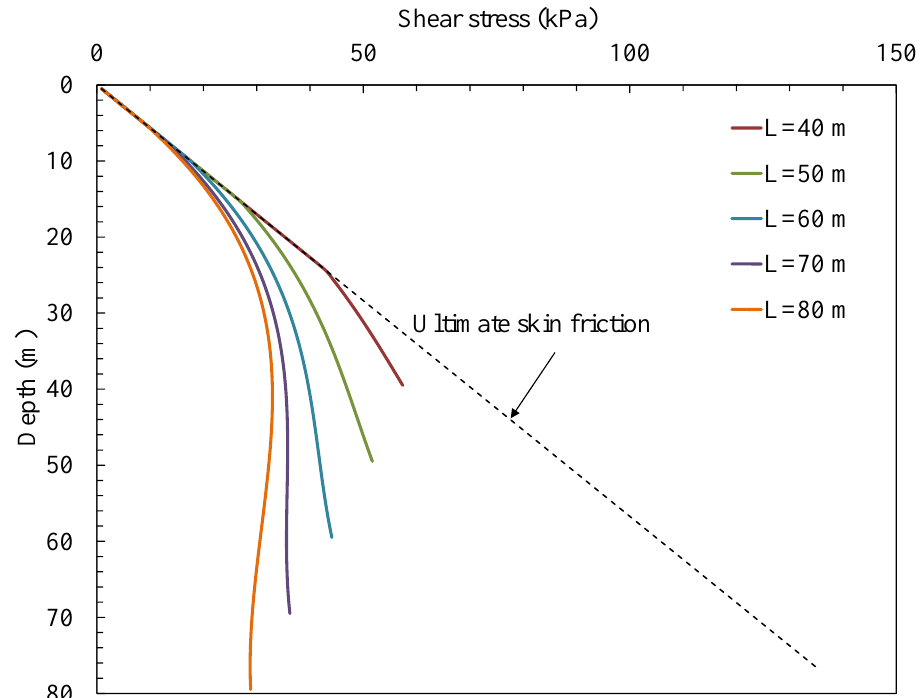
Figure 18. Effect of pile length on development of skin friction.